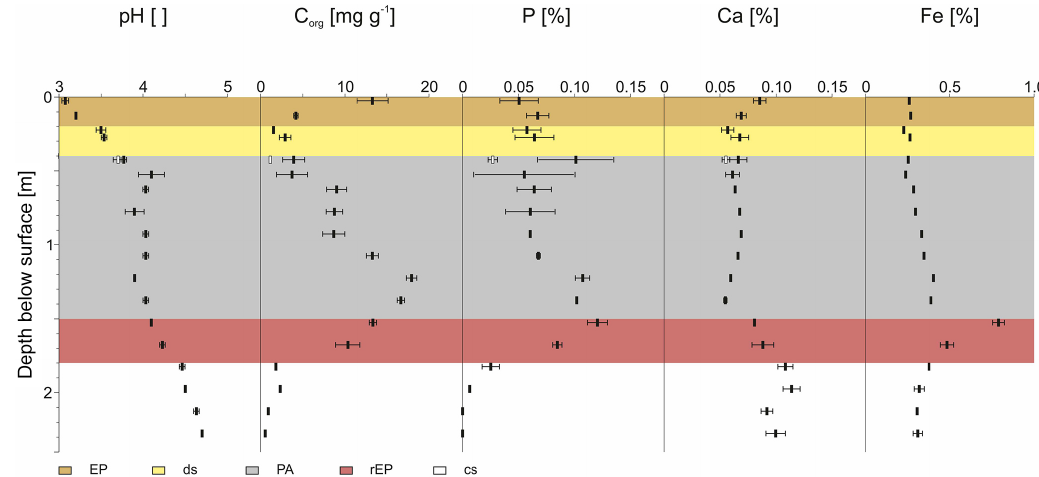
Figure 4. Geochemical properties of the profile, including pH, C org contents, and weight percentages of P, Ca and Fe. Symbol and column height represent thickness of sampled interval (0.05m). At 0.4m depth, drift sand (white symbols) and PA (black symbols) were analyzed separately.